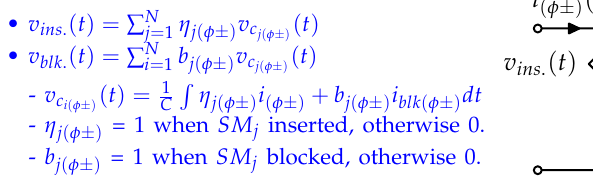
Figure 6. Arm switching function model (SFM) using generic EMT blocks